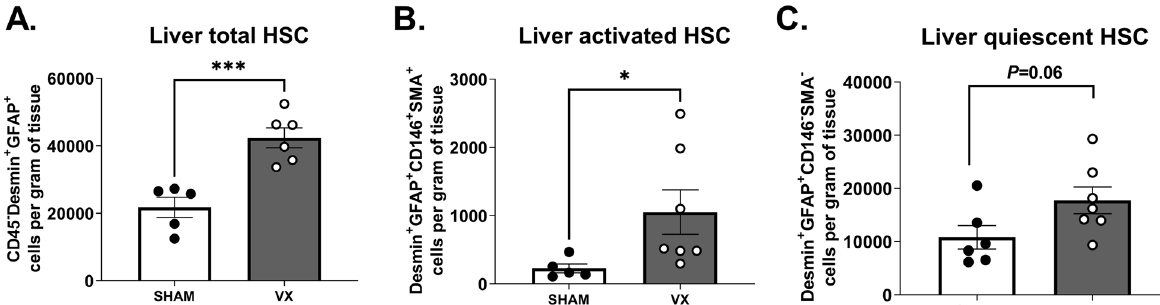
Fig. 5 Higher activation of hepatic stellate cells in acute inflammation in vagotomized mice. Wild-type C57BL/6J mice were subjected to either left cervical unilateral vagotomy (VX, grey bars) or sham surgery (SHAM, white bars). After 7 days, mice were injected intraperitoneally with zymosan (0.1 mg/mouse) and euthanized 12 h thereafter. Liver homogenates were analyzed for ( A ) CD45 − Desmin + GFAP + HSCs, ( B ) CD45 − Desmin + GFAP + CD146 + SMA + activated HSCs, and ( C ) CD45 − Desmin + GFAP + CD146 − SMA. − quiescent HSCs, and normalized by liver biopsy mass (g). n 6–7 per group. Results are shown as mean SEM. ns not significant; * p < 0.05, *** p < 0.001 (two-sided Student t -test; Welch’s test = ± = correction was applied when variances were significantly